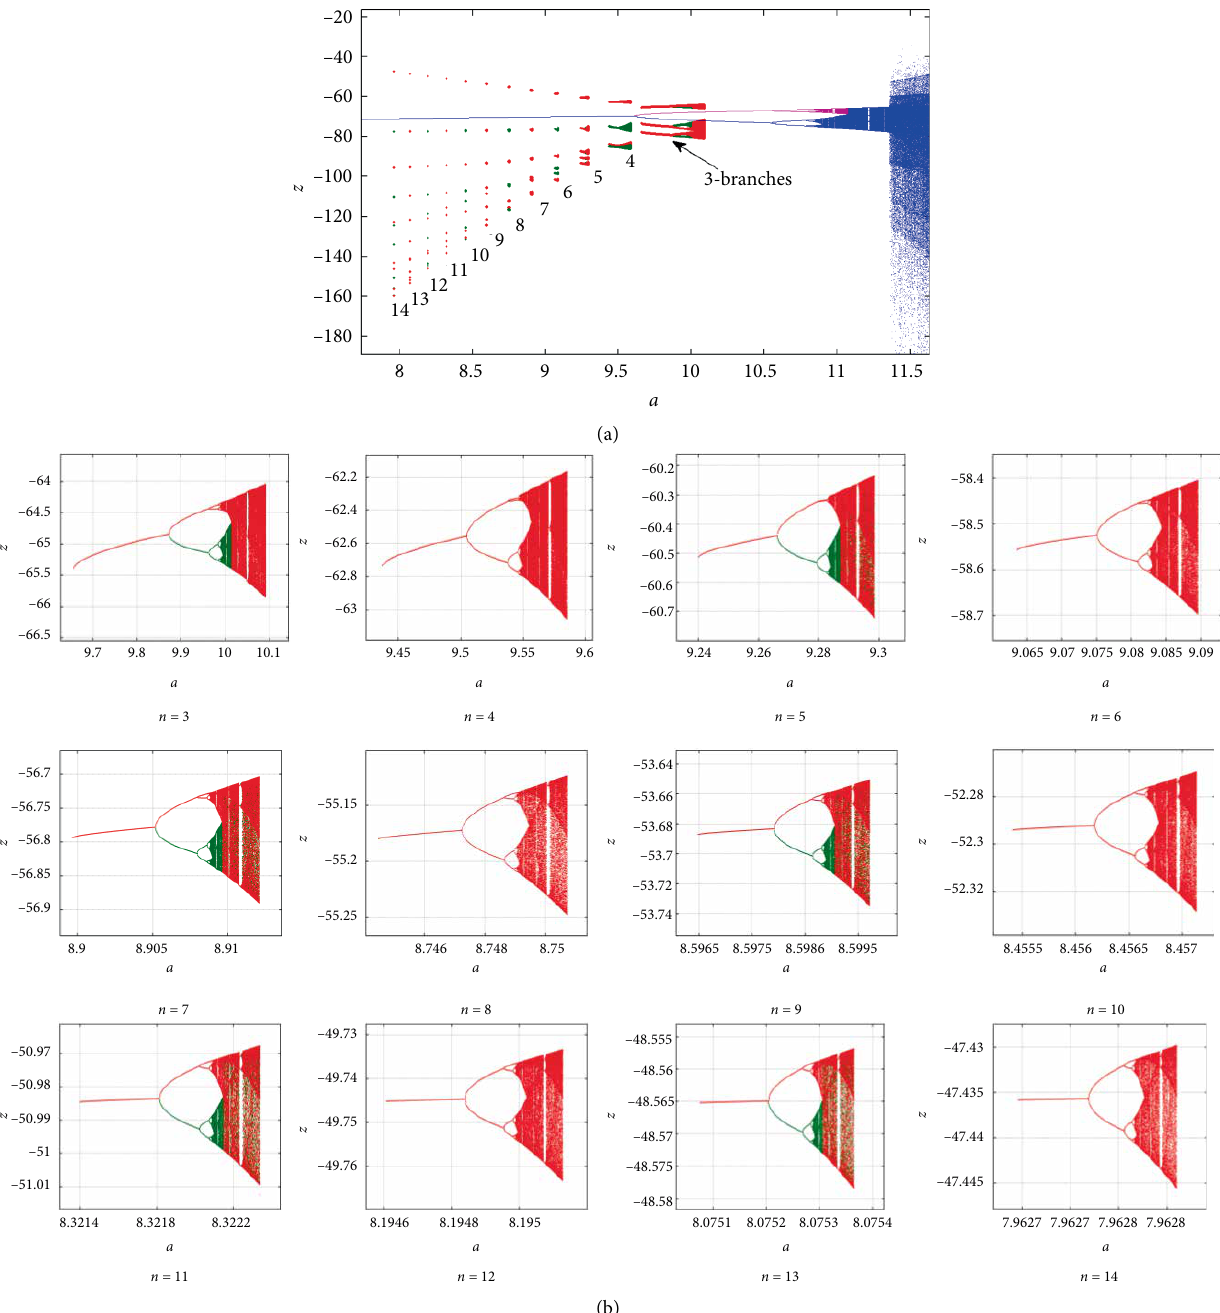
Figure 1: Sequence of routes with 𝑛 sub-branches to